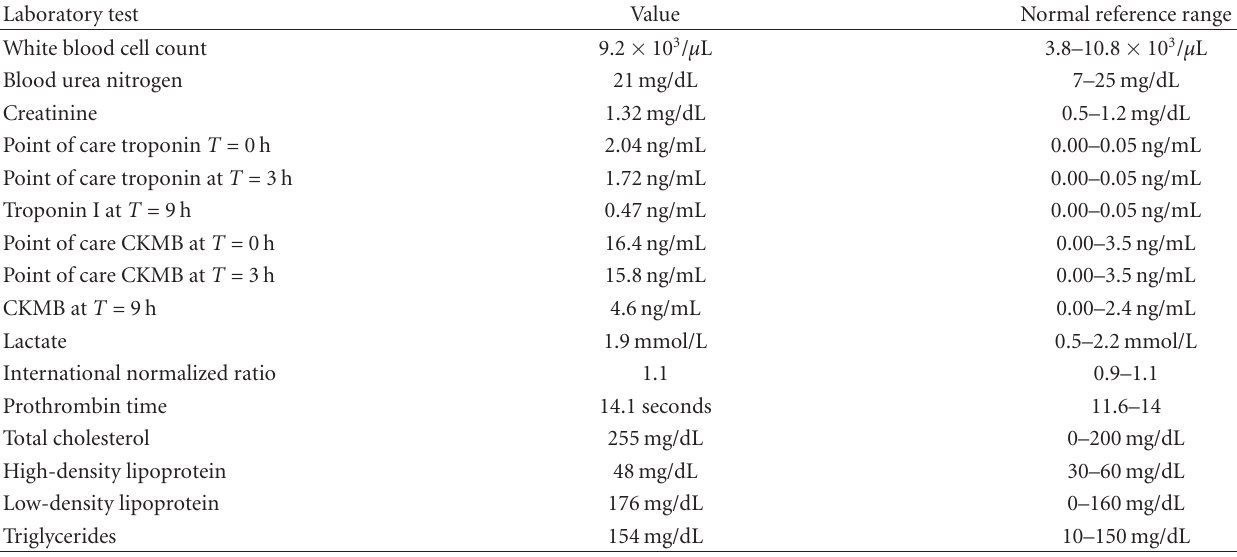
Table 1: Pertinent laboratory data. Values and normal reference range noted for each laboratory test. All reported data is from time of presentation to emergency department unless otherwise